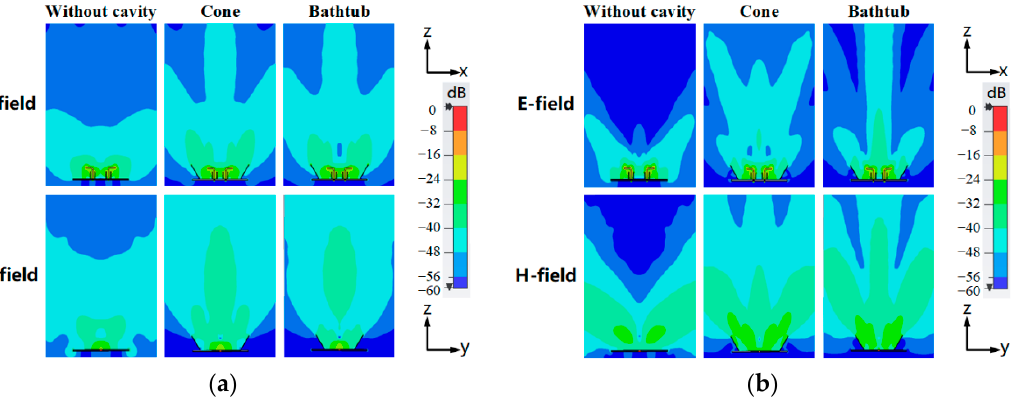
Figure 9. Uniform electric and magnetic field distribution of the antennas at different frequencies. ( a ) 6 GHz. ( b ) 9 GHz.